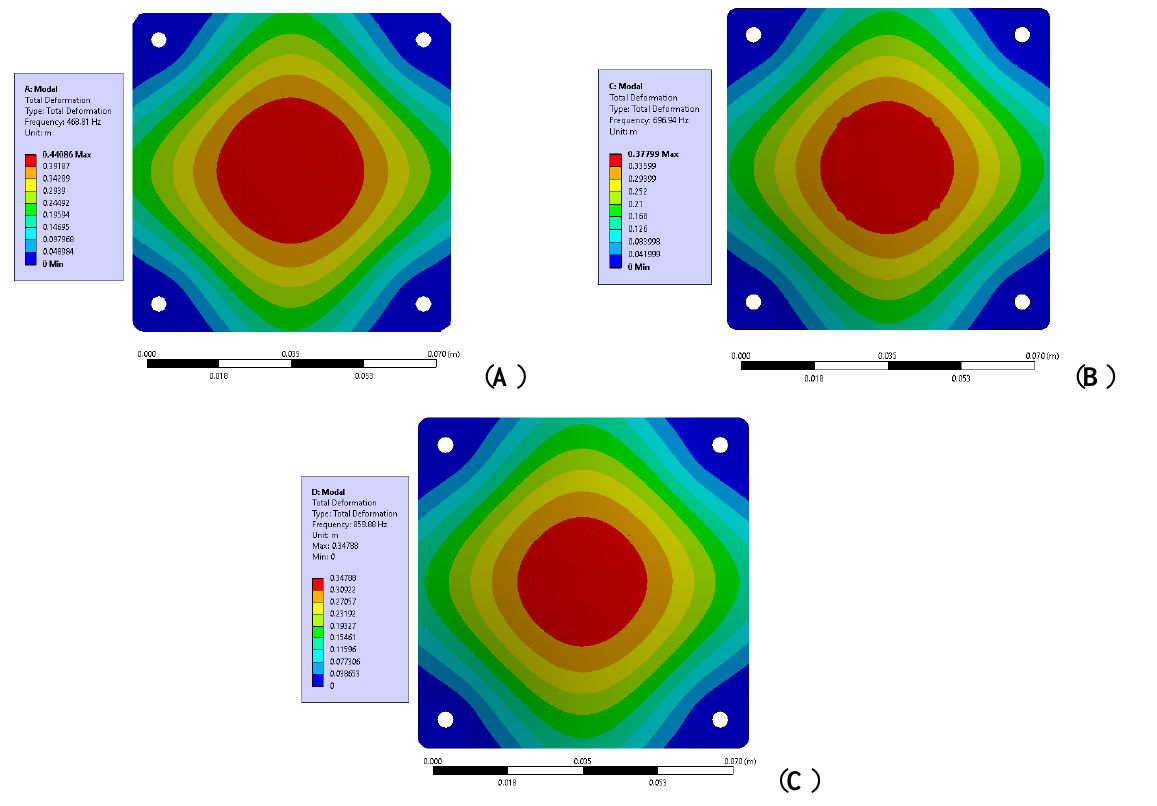
Figure 10. First mode response of the test vehicle obtained from simulation with different board thickness ( A ): 1 mm, ( B ): 1.6 mm, ( C ): 2 mm.